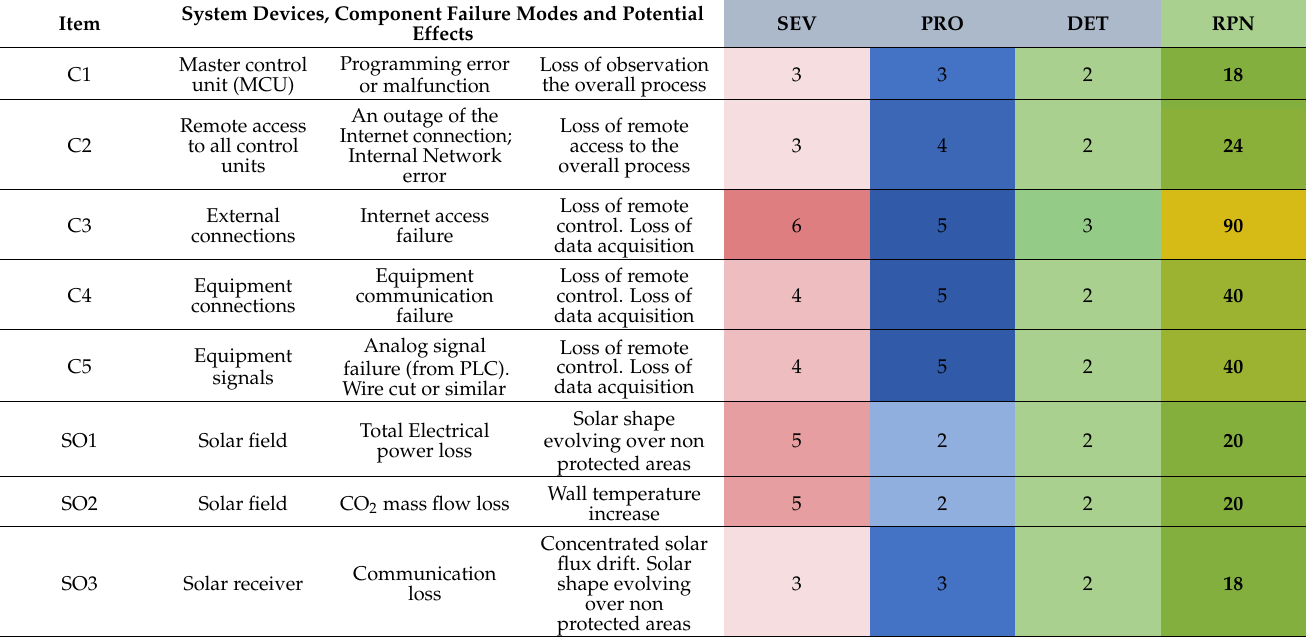
Table 6. Data collection and risk assessment of the FMEA analysis of the solar side, control, and power block systems.